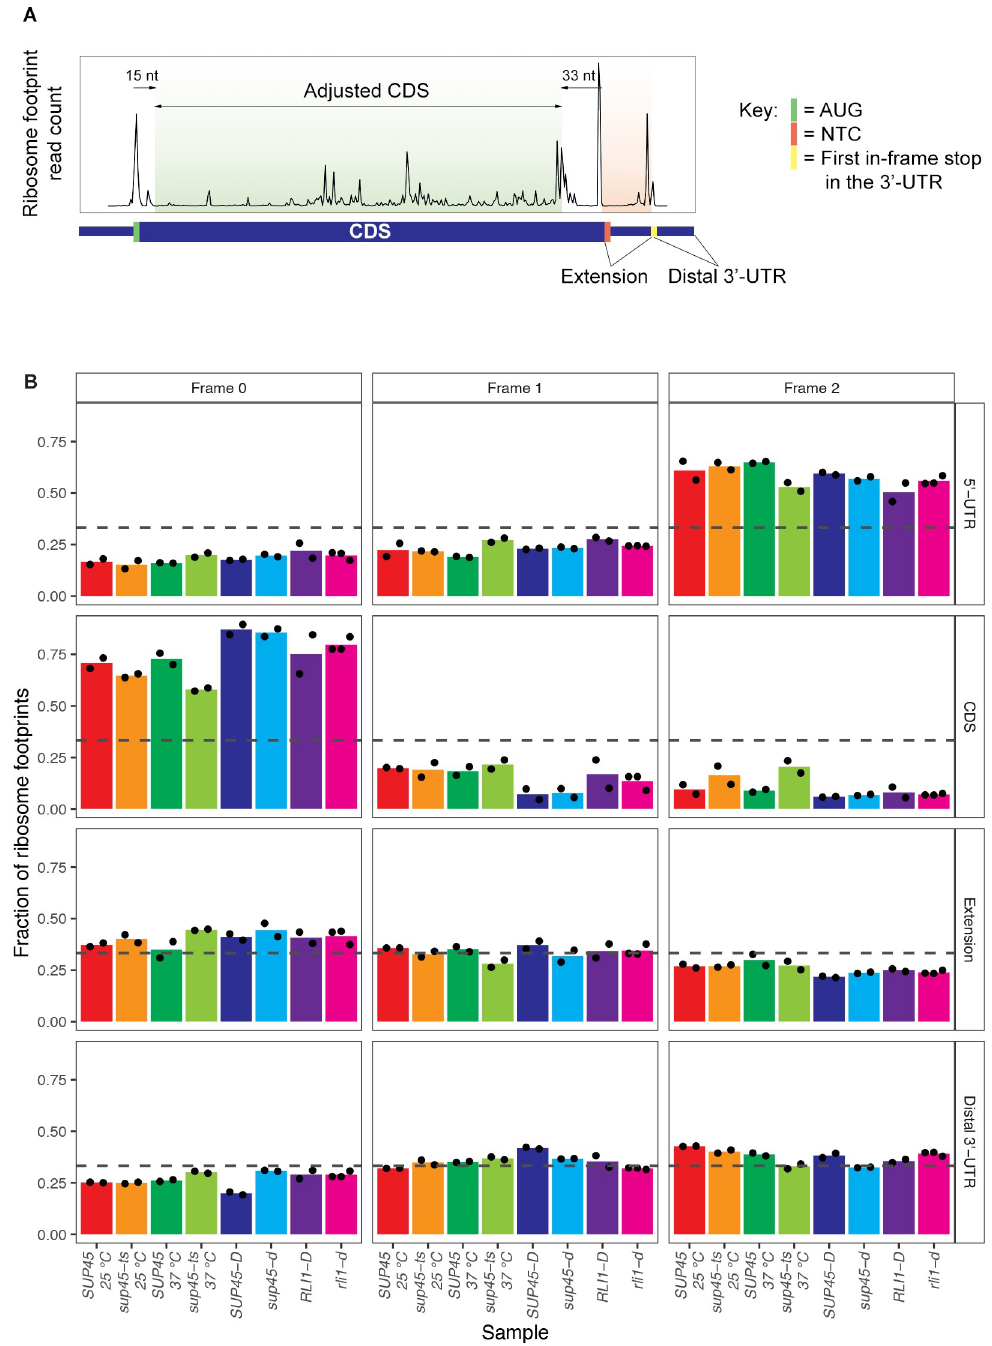
Fig 2. Readthrough events were characterized by maintenance of reading frame when ribosomes bypass the stop codon. A. Example of ribosome footprint count plot with labeled mRNA regions of interest. B. Fractions of reads in each of the three reading frames for different mRNA regions. The results of each sample were the average of 2 or 3 replicates, with black dots indicating individual data points. The dashed line drawn at 0.33 is the theoretical fraction at which all 3 reading frames are represented in equal